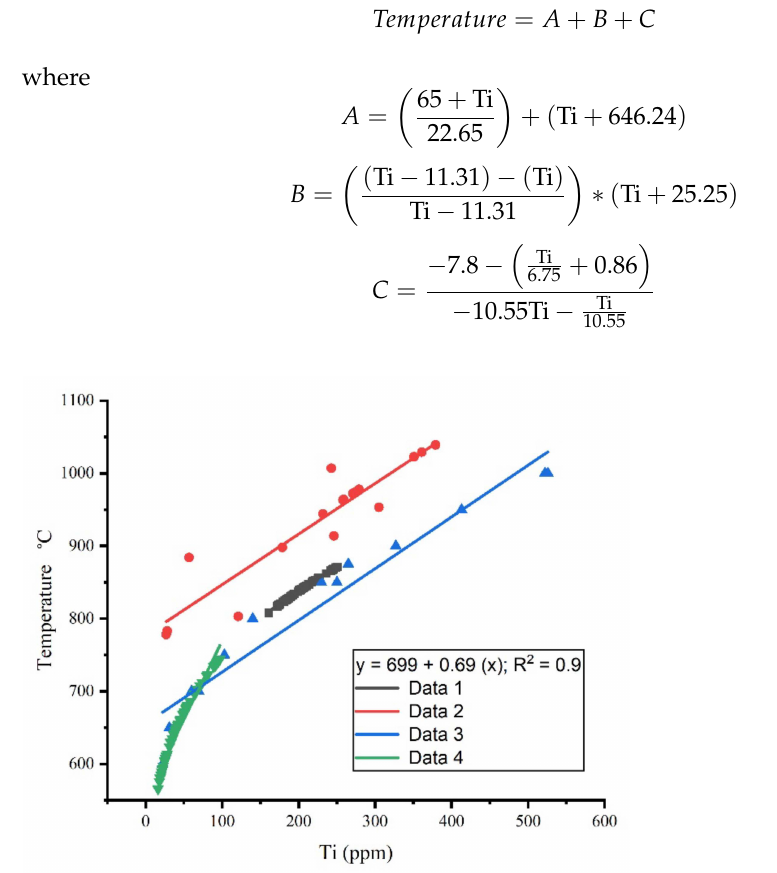
Figure 1. Displayed temperature increase with increasing Ti content: Data 1 (black dots), Data 2 (red dots), Data 3 (blue triangle), and Data 4 (green triangle) are collected from [8,41,63,64],